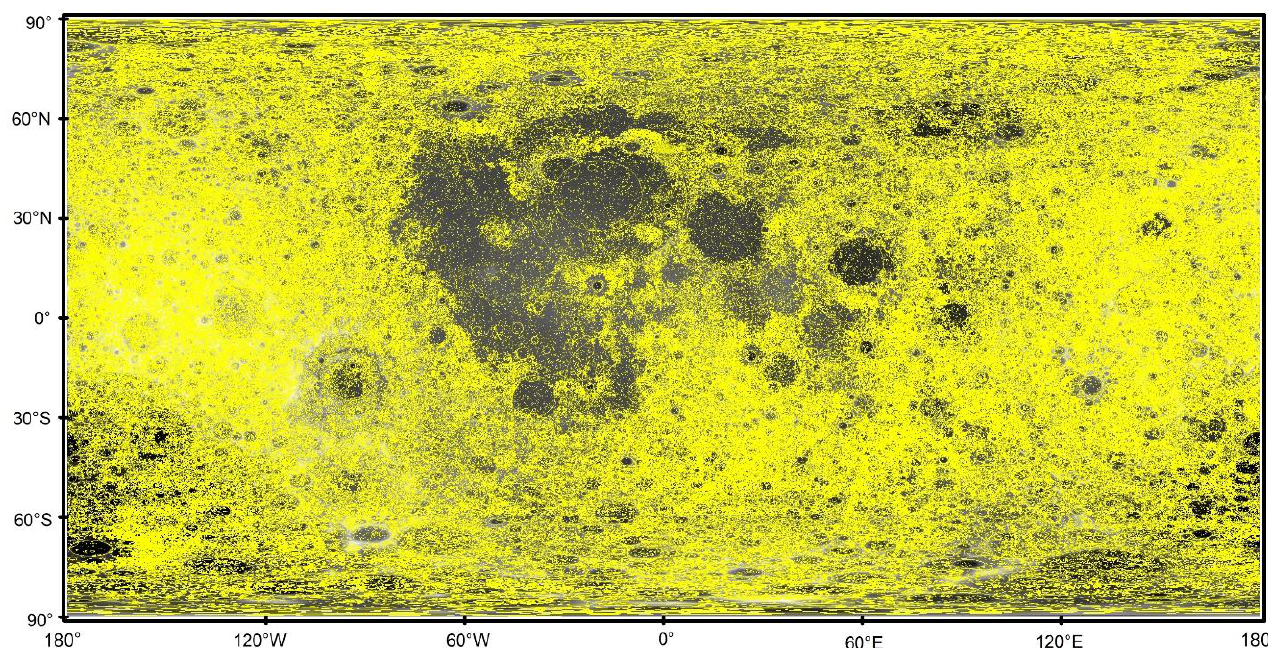
Figure 3. The new global catalogue of lunar craters (≥1 km) overlaid on the SLDEM and